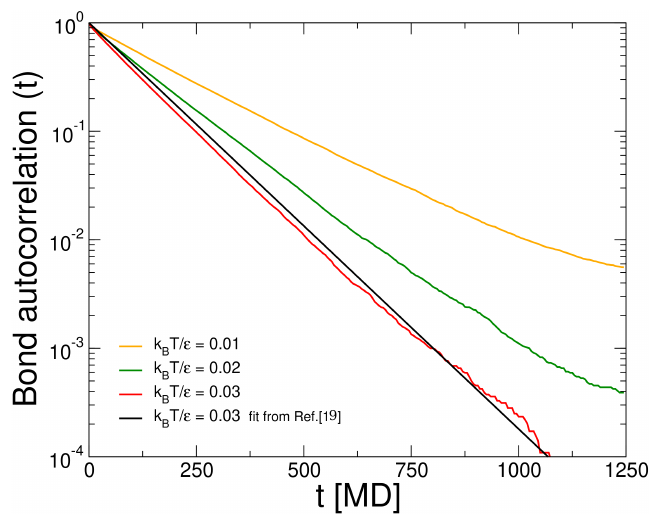
Figure 3: Bond autocorrelation function for a binary mixture of WCA particles with the additional three body potential in eqn (2). Its decay is exponential and the char- acteristic time depends on the temperature. Here we show that our HOOMD-blue implementation is compatible with Ref. [ 19 ]